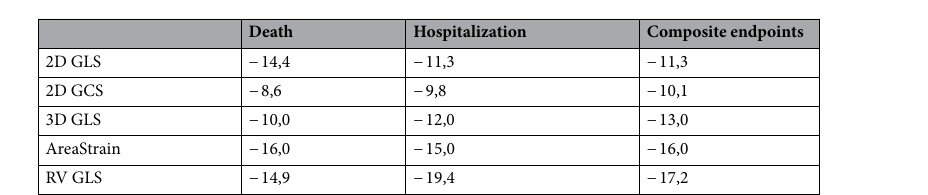
Table 6. STE parameters´ cut off values for prediction of events in 5 years of follow up. 2D GLS Two- dimensional global longitudinal strain, 2D GCS Two-dimensional global circumferential strain, 3D GLS Three- dimensional global longitudinal strain, RV GLS Right ventricular global longitudinal strain.